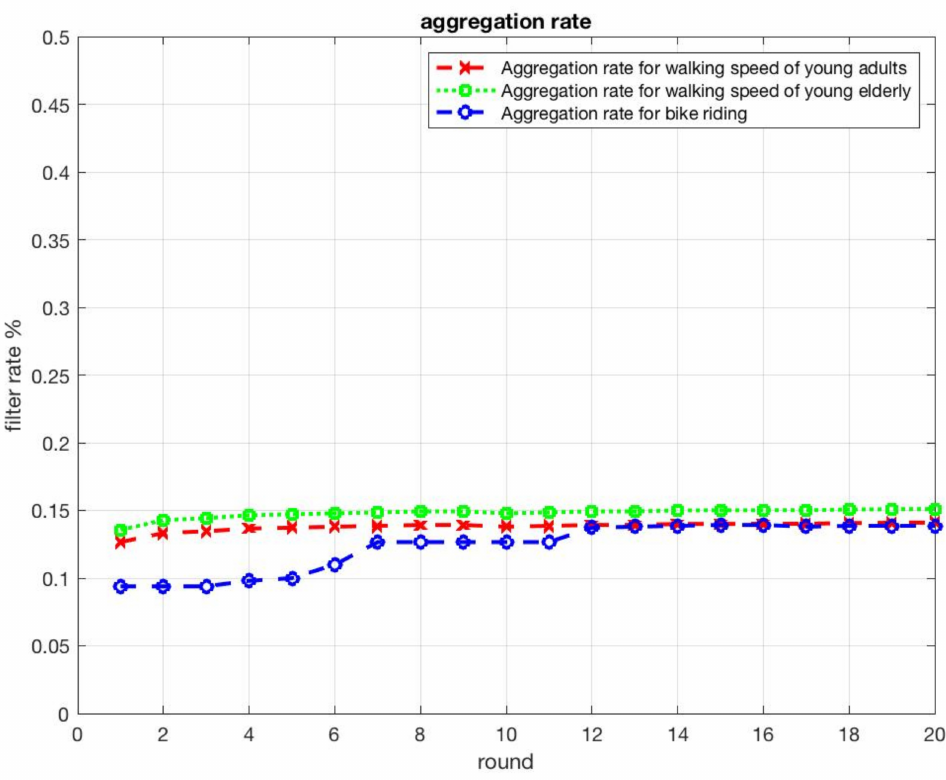
Figure 16. Aggregation